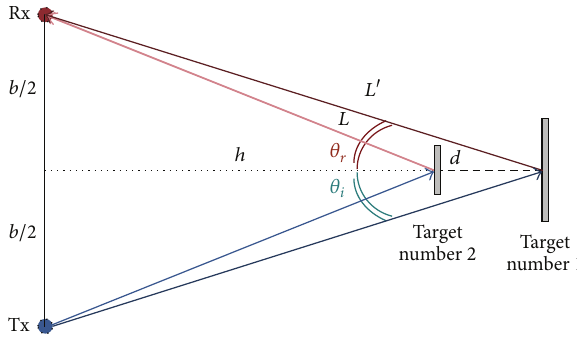
Figure8:Geometrysetupfordoubletargetdetectionmeasurement: 𝑏 = 3.35 m, ℎ = 31.07 m, 𝐿 = 31.1 m, 𝐿 󸀠 = 37.6 m, 𝜃 𝑑 = 6.5 m.